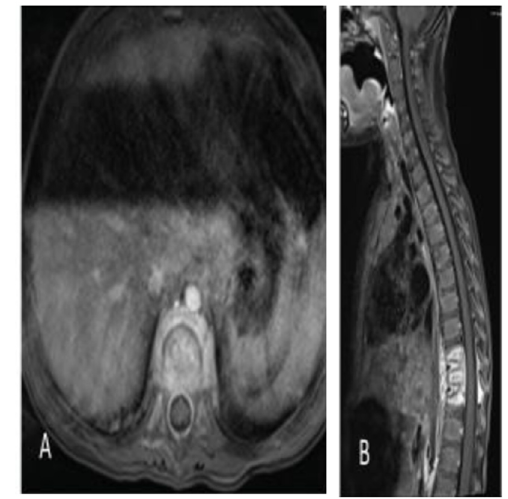
Figure 3. Axial ( A ) and sagittal ( B ) fat-saturated volumetric interpolated breath-hold examination (VIBE) postcontrast magnetic resonance imagery (MRI) images of the thoracic spine demonstrate multilevel thoracic osteomyelitis and discitis with associated epidural and paravertebral abscesses. Figure 2. Skin punch biopsy demonstrates acute suppurative